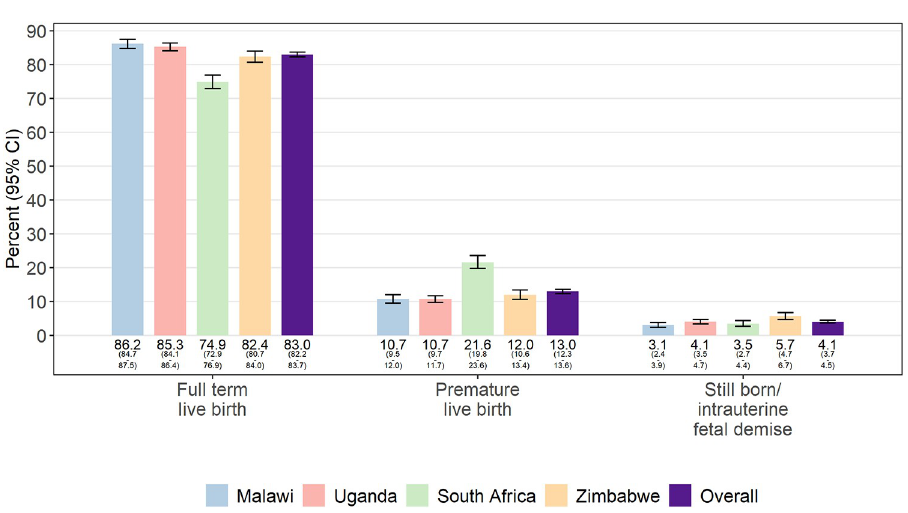
Fig 1. Frequency of pregnancy outcomes by site. Data on pregnancy outcomes, overall and by site, for n = 10,180 pregnancy outcomes. Records where the pregnancy outcome could not be ascertained were excluded.